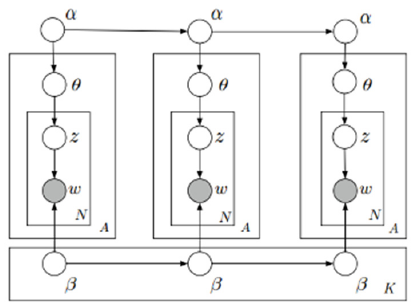
Figure 3. Graphical representation of a dynamic topic model.